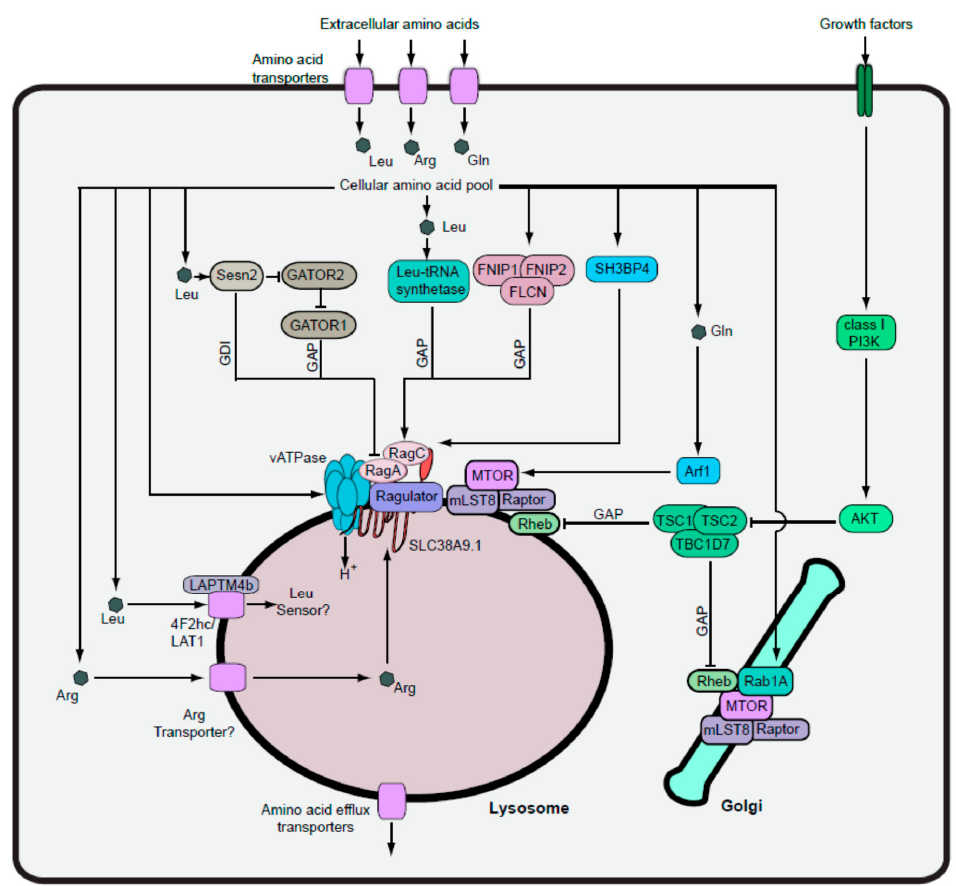
Figure 3. Circuitry of amino acid signalling to MTORC1 . Extracellular amino acids are first transported into the cell. Regulatory amino acids such as Leu and Arg are further transported into the lysosome. Lysosomal Arg is sensed via SLC38A9.1, leading to activation of the vATPase-Ragulator complex and MTORC1. Leu is sensed via Sesn2 to regulate the GATOR1 pathway. Gln activates MTORC1 via an Arf1-mediated pathway. Amino acids also activate MTORC1 at the Golgi via Rab1A. Growth factor signalling leads to activation of PI3K and AKT, which controls the TSC1/2 complex and Rheb.